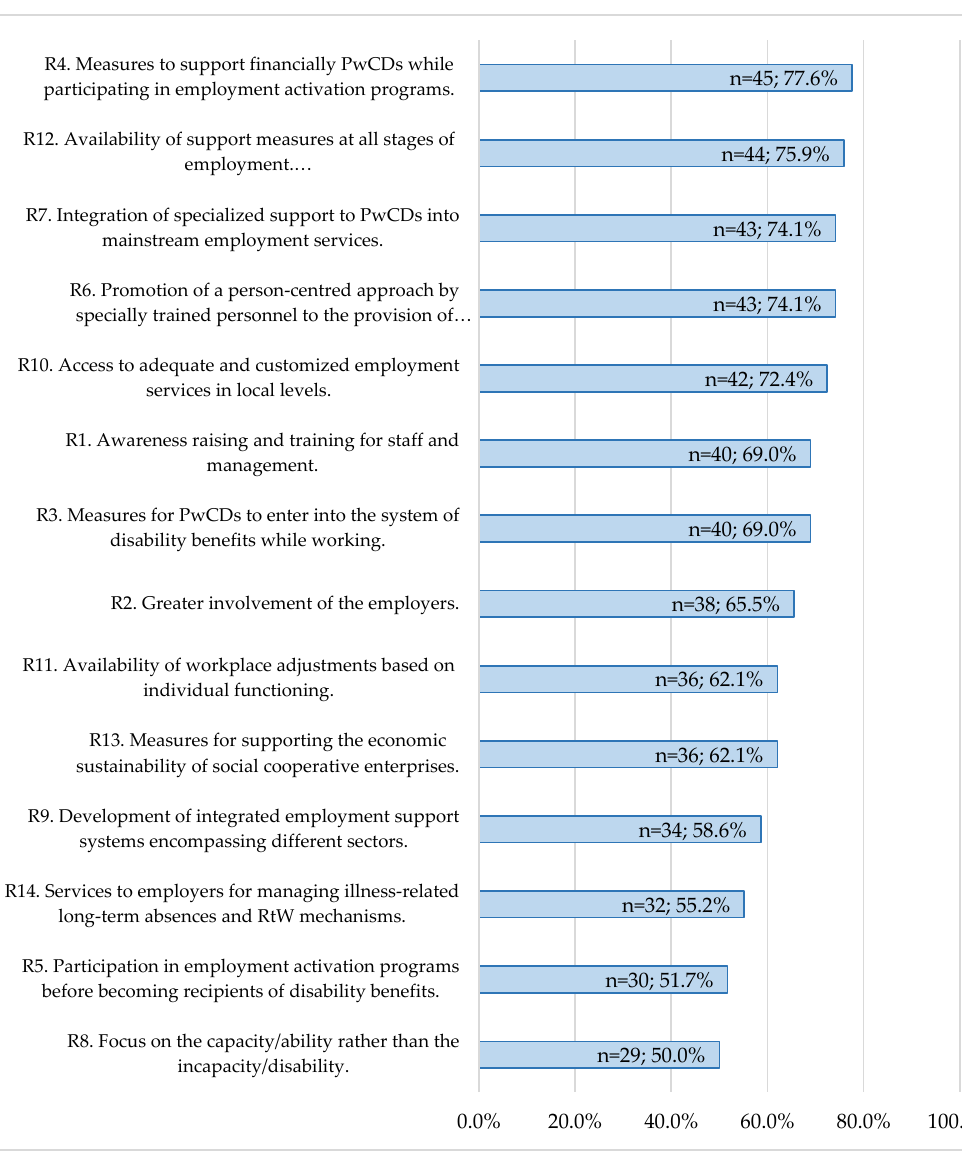
Figure 2. Recommendations “partially” and “fully implemented” according to national stakeholders’ views.